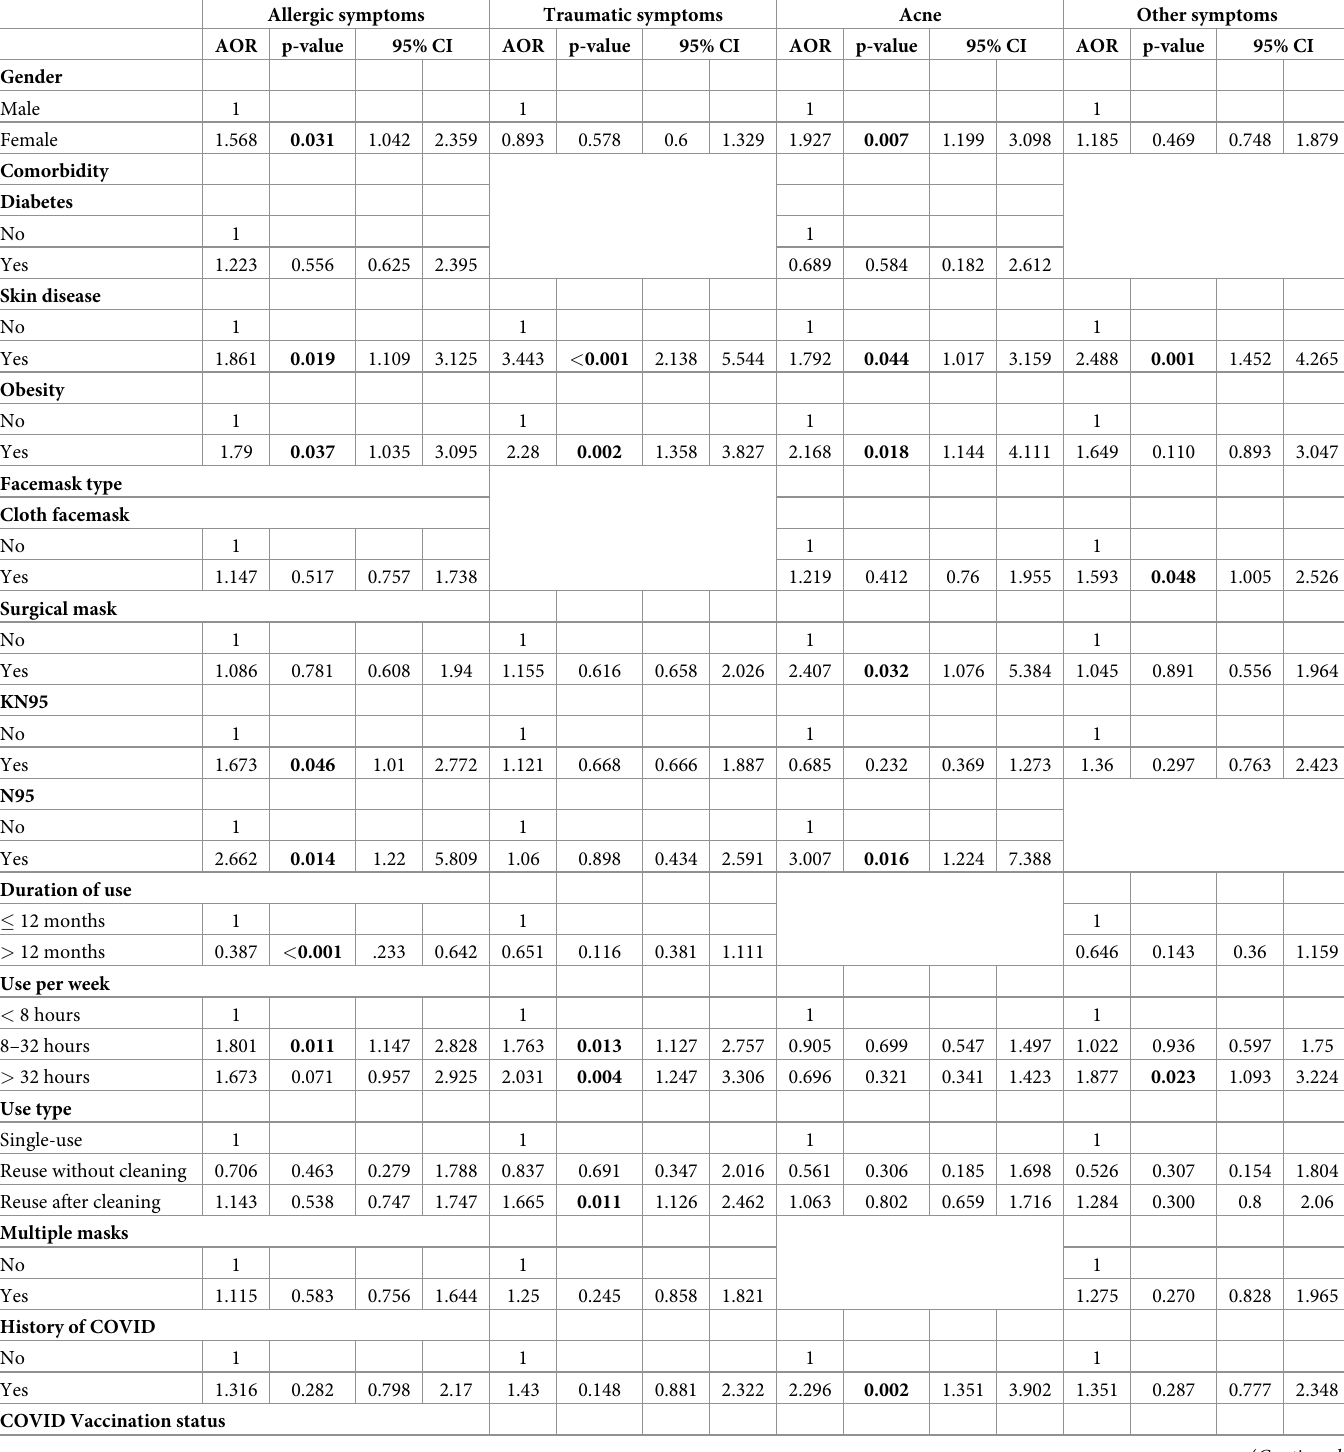
Table 3. Multivariate logistic regression analysis of face mask related skin manifestations and associated factors (N =